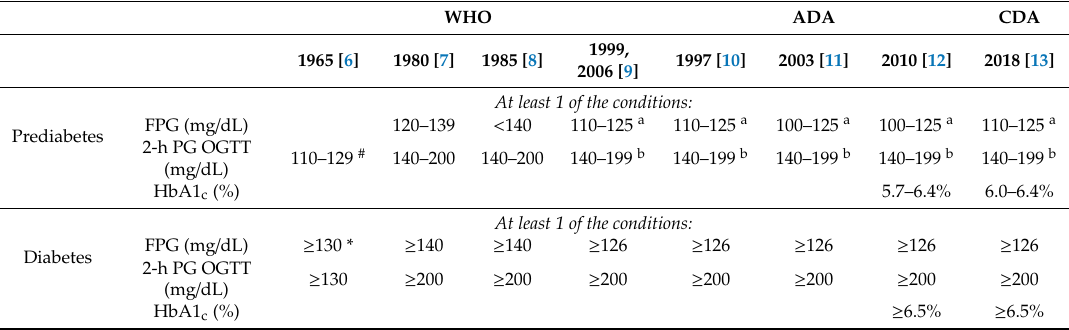
Table 1. History of diagnostic criteria for prediabetes and diabetes mellitus (DM).